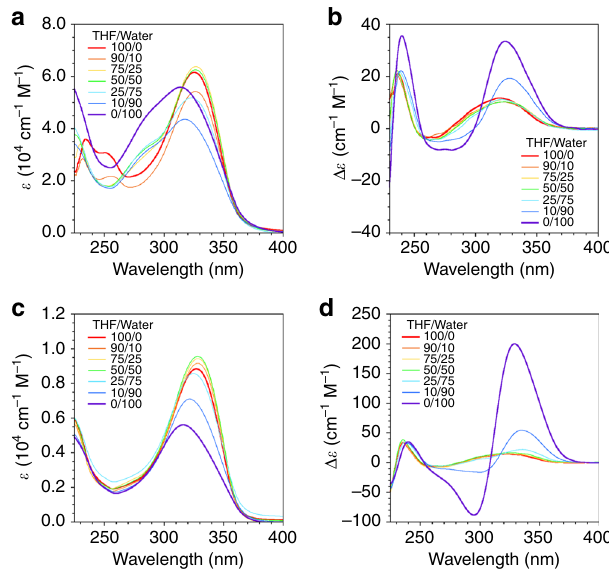
Fig. 2 Spectroscopic characterization of self-assembly of multiblock amphiphiles upon solvent polarity change. a , c UV-vis absorption and b , d CD spectra of a , b 1mer and c , d 2mer in the mixture of THF and water at 20 °C. [ 1mer ] = 14 μ M. [ 2mer ] = 7.0 μ